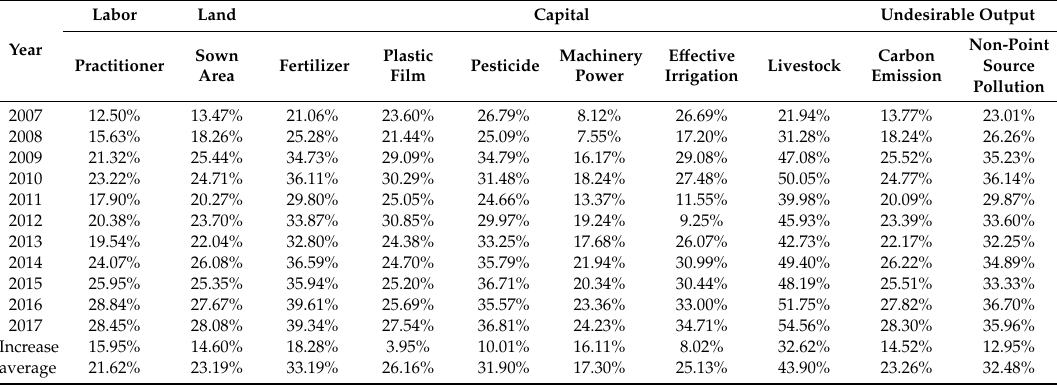
Table 5. Redundancy rate of each input–output indicator of cultivated land use e ffi ciency from 2007 to